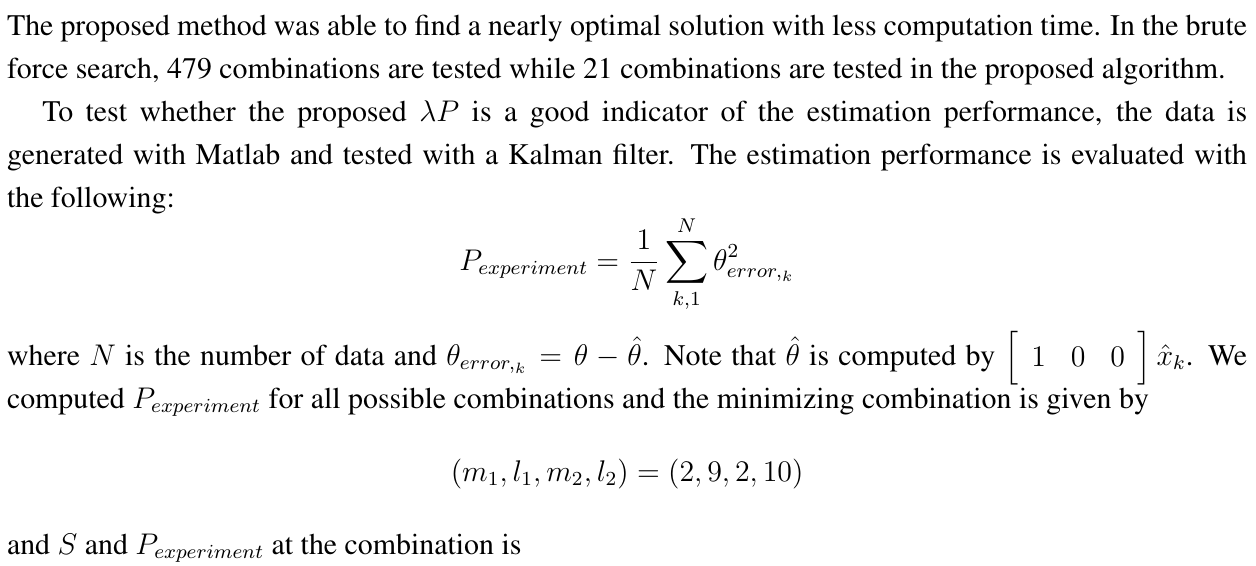
; l ) = (2 ; 9) (o: S ≤ S 1 1